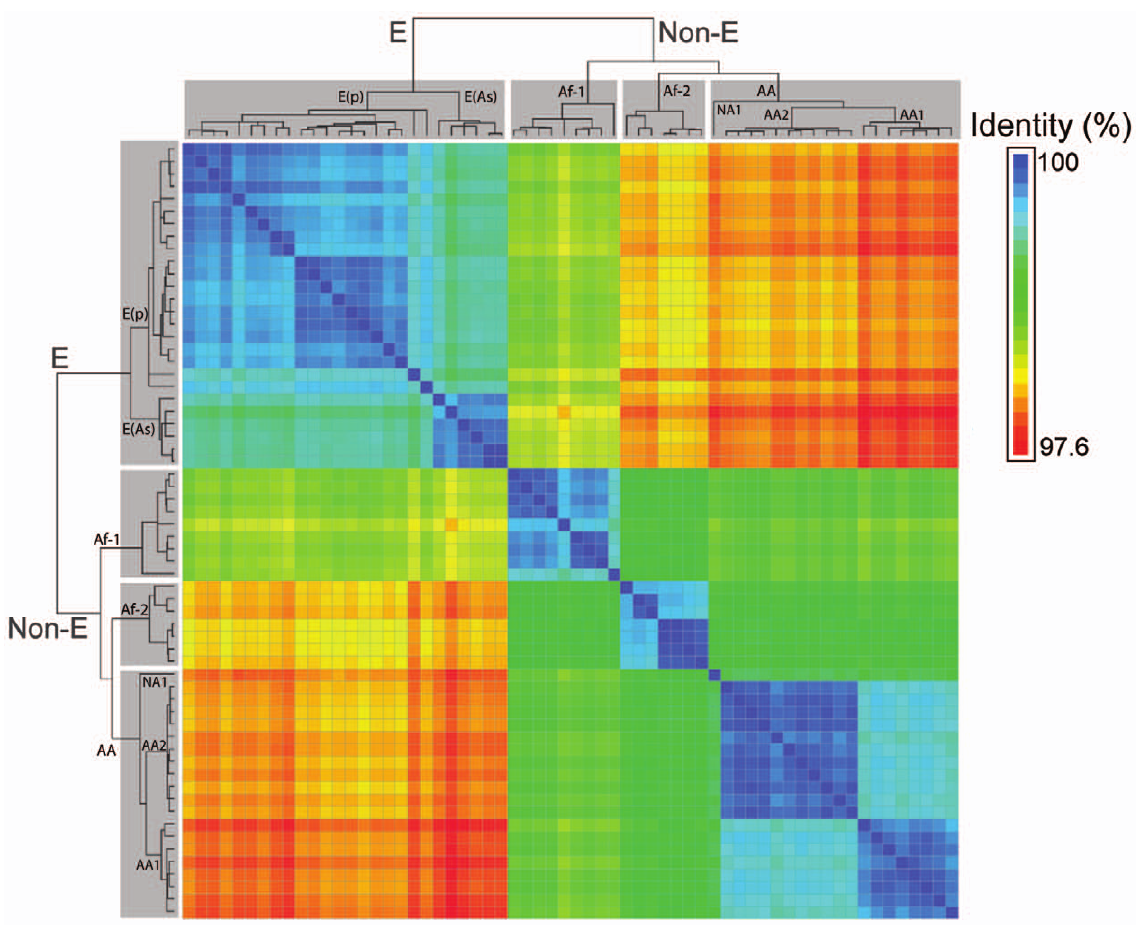
Figure 2. HPV16 phylogeny and heatmap of HPV16 isolates in the reference panel. All 62 nucleotide sequences in the HPV16 complete- genome reference panel were aligned and compared to one another. Sequence identity between every pair was measured and represented as a heatmap, scaled such that the minimum inter-sequence identity (97.6%) is displayed as red and the maximum inter-sequence identity (100%) as blue. A Bayesian phylogenetic tree is shown alongside the heatmap to illustrate how the inter-sequence identities relates to the phylogenetic topology. Major lineages (highlighted in gray) and sublineages are labeled and all have 100% bootstrap support.